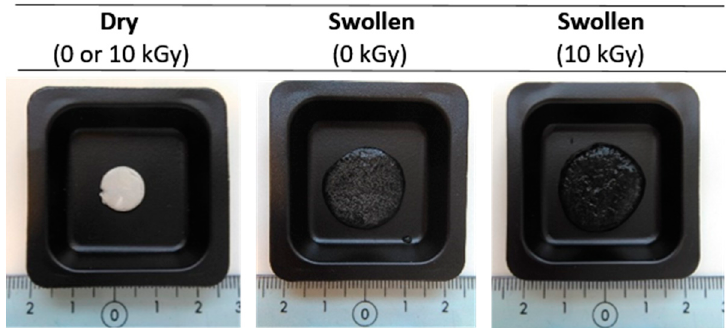
Figure 6. Macroscopic view of non-irradiated and γ -irradiated BF chitosan/PVP matrices in dry and swollen state.